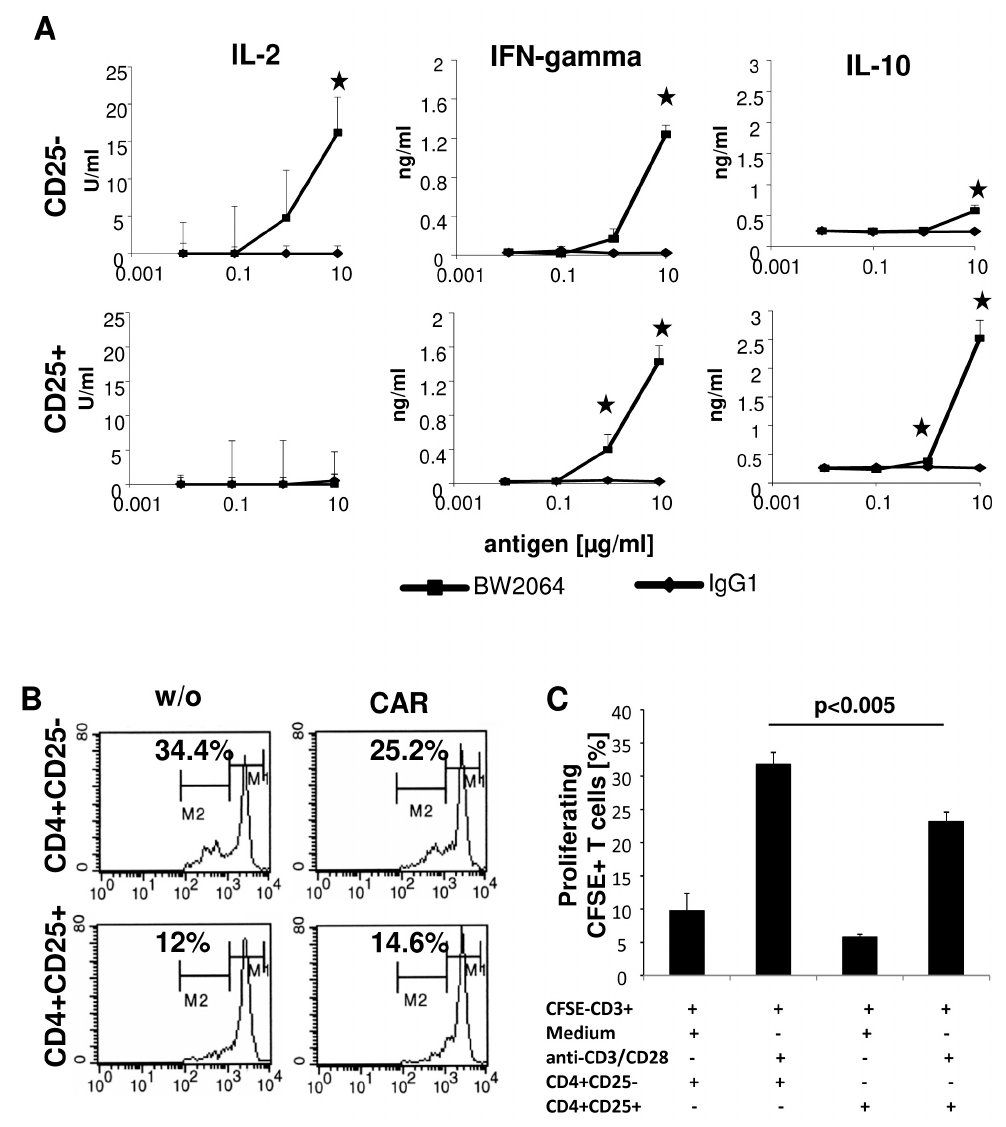
Figure 2. CD4 + T cells release a distinctive set of cytokines upon CAR mediated activation. ( A ) CD4 + CD25 − and CD4 + CD25 + anti-CEA CAR T cells (10 4 /well) were incubated in micro-titer plates coated with serial dilutions of the CAR specific anti-idiotypic monoclonal antibody (mAb) BW2064 or an IgG1 isotype control mAb (0.01–10 µ g/mL) and cultivated for 48 h. Supernatants were recorded for cytokines by ELISA. Data represent the mean of technical replicates ± SD. Significant differences were calculated by the Student’s t test and significant data ( p < 0.05) were indicated by asterisks. Representative results out of three experiments are shown. ( B , C ) Freshly isolated CD3 + T cells were labeled with CSFE and coincubated (5 × 10 4 cells/well) either with non-labeled CD4 + CD25 − and CD4 + CD25 + CAR T cells (B,C), respectively, or non-modified T cells (w/o) (5 × 10 4 cells/well) in the presence of the agonistic anti-CD3 mAb OKT3 (10 µ g/mL) and anti-CD28 mAb 15E8 (1 µ g/mL). After 5 days cells were recovered, pooled and CFSE-labeled cells were determined by flow cytometry ( B ). Cells of technical replicates were recovered and the numbers of cycling CFSE-labeled cells were recorded by flow cytometry ( C ). Numbers represent mean values ± SD. Significant differences were calculated by the Student’s t test. A representative experiment out of three is shown.